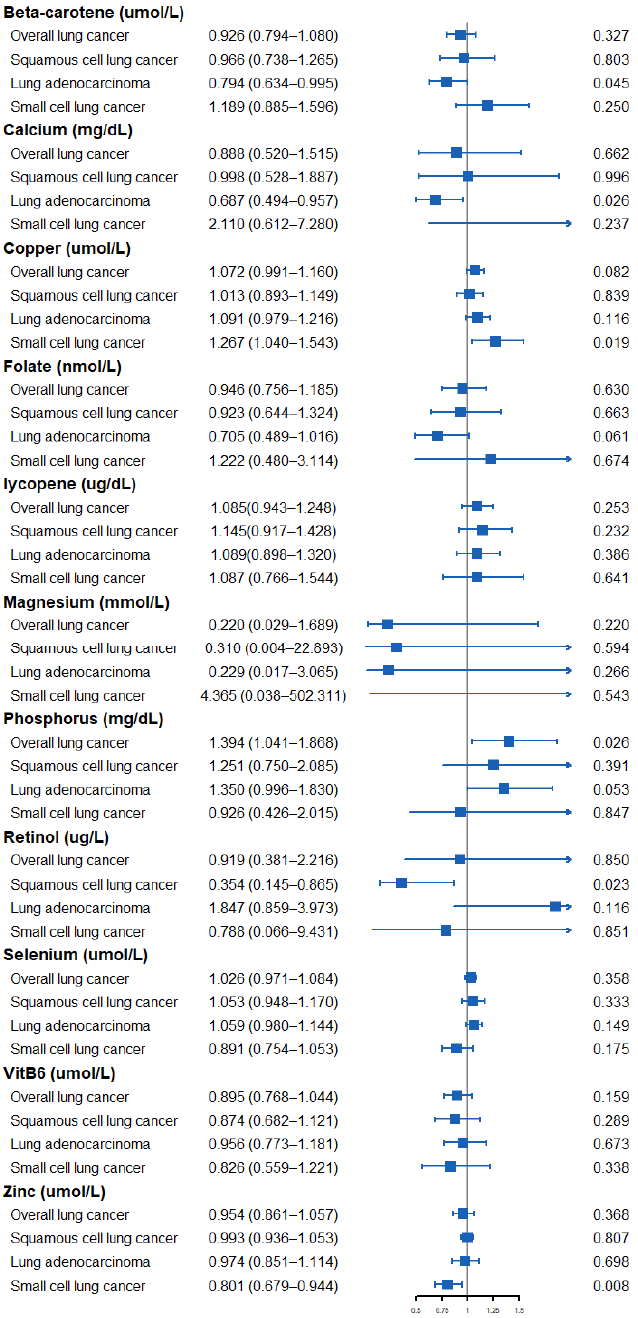
Figure 2. Forest plot showing results from Mendelian randomization study to assess potential causal associations between 11 micronutrients and lung cancer, including overall lung cancer, lung adenocarcinoma, squamous cell lung cancer, and small cell lung cancer.